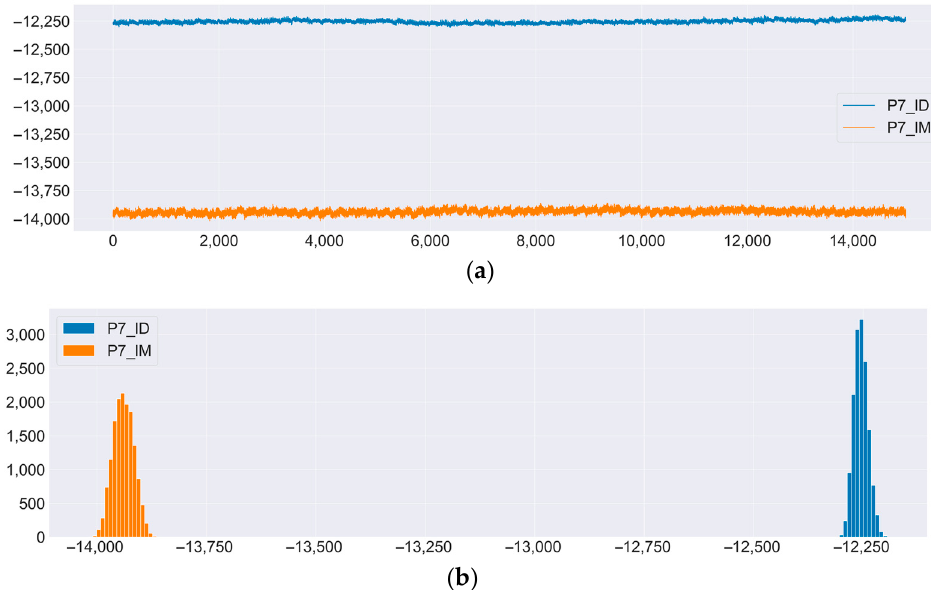
Figure 7. Signals from sensor P7 for two participants. ( a ) Signal changes over time. ( b ) Distribution of values for each of the signals. It is clearly seen that for the P7_IM signal, all values were grouped in the − 14,000 microvolt region, while for the P7_ID signal, these values were in the − 12,250 micro- volt region.